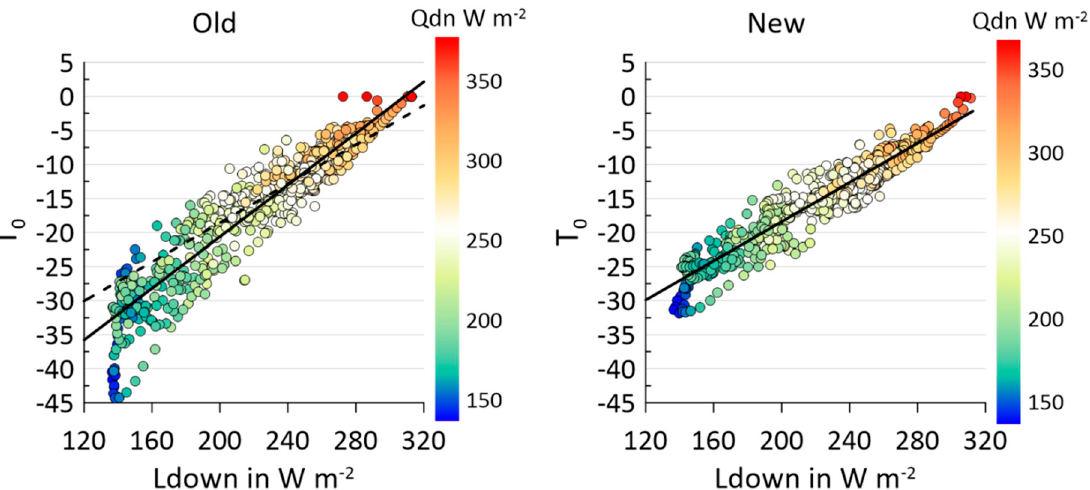
Figure 15. Scatter plots of the surface temperature against downward longwave radiation as simulated by CCLM for the old version ( left ) and the new version ( right ). The color code is the available radiative energy (Qdn = K * + Ld). Full lines are the regression of the respective data, the dashed line in the left panel is the regression of the new version.